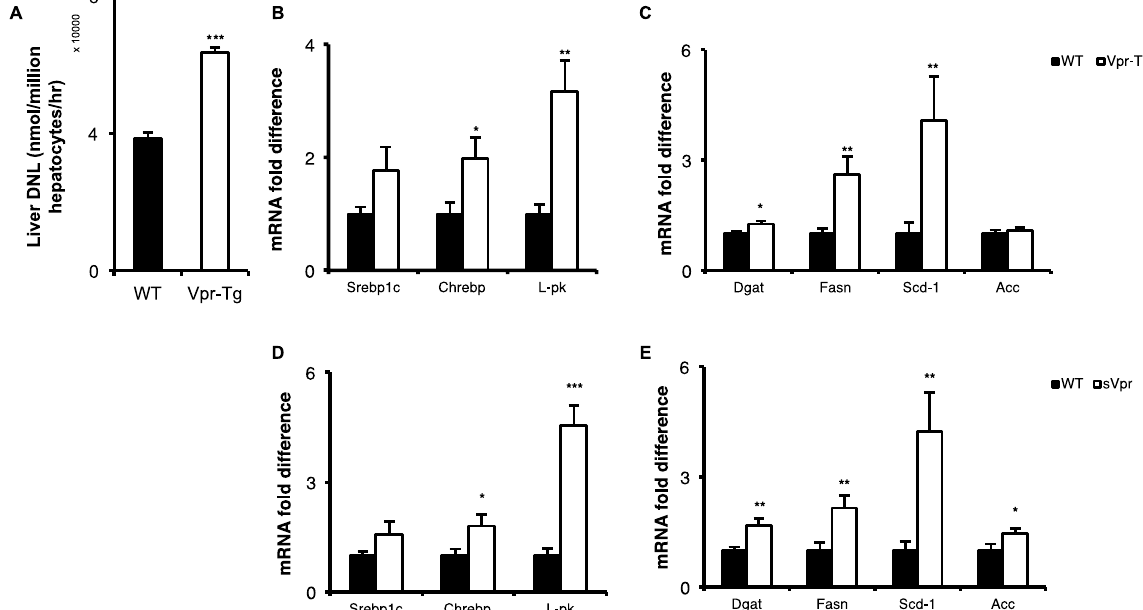
Figure 2. Increased de novo lipogenesis and mRNA levels of LXR-regulated lipogenic genes in liver of Vpr-Tg and sVpr-treated mice. ( A ) Faster conversion of [ 14 C]acetate into [ 14 C]-labeled fatty acids in primary hepatocytes was noted in Vpr-Tg compared to WT mice (N = 3 per group). ( B ) Increased mRNA levels of Chrebp and its target Lpk were present in Vpr-Tg compared to WT mice (N = 8 per group). ( C ) mRNA levels of Dgat, Fasn and Scd1 were present in Vpr-Tg compared to WT mice (N = 8 per group). ( D ) mRNA levels of Chrebp and Lpk were increased, and there was a trend towards increased mRNA level of Srebp1c (P = 0.077), in sVpr-treated compared to vehicle-treated mice (N = 8 per group). ( E ) Increased mRNA levels of Dgat, Fasn, Scd1 and Acc were noted in sVpr-treated compared to vehicle-treated mice (N = 8 per group). Values are mean ± SE. * P < 0.05, ** P < 0.01, *** P <